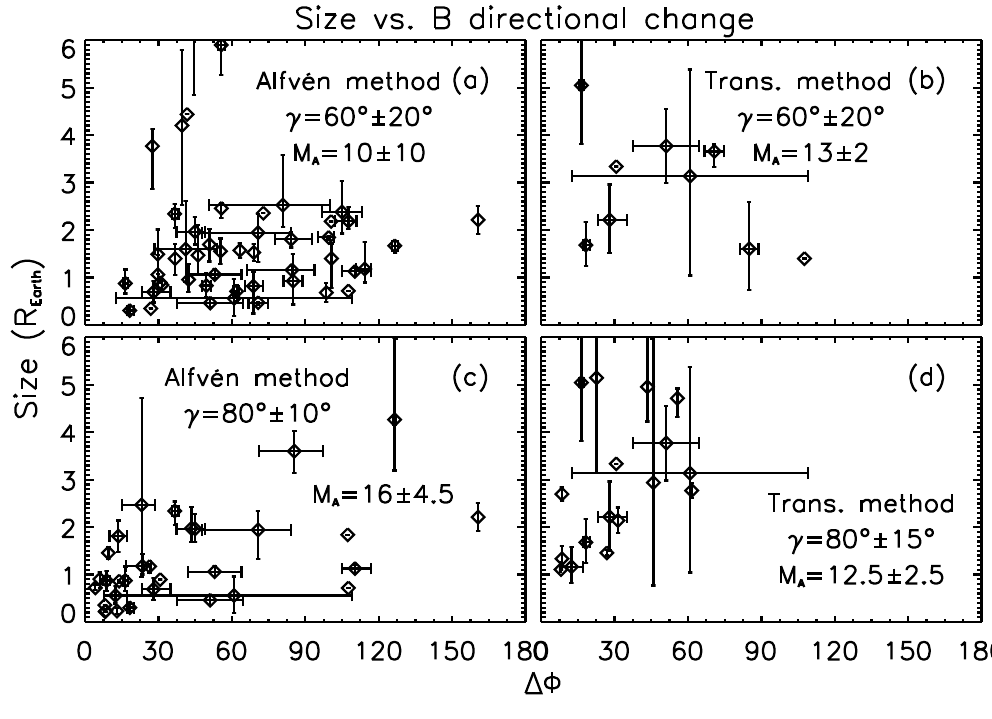
Fig. 7. The size- 18 functions based on the size estimation by Alfv´en Mach velocity on the left and the transition speed on the right. The fixed solar wind speed was shown in Alfv´en Mach number. (a) γ = 60 ◦ ± 20 ◦ and M A = 10 ± 10, (b) γ = 60 ◦ ± 20 ◦ and M A = 13 ± 2, (c) γ = 80 ◦ ± 10 ◦ and M A = 16 ± 4 . 5, (d) γ = 80 ◦ ± 15 ◦ and M A = 12 . 5 ± 2 . 5. All Alfv´en Mach numbers were calculated from the actual Alfv´en velocity.